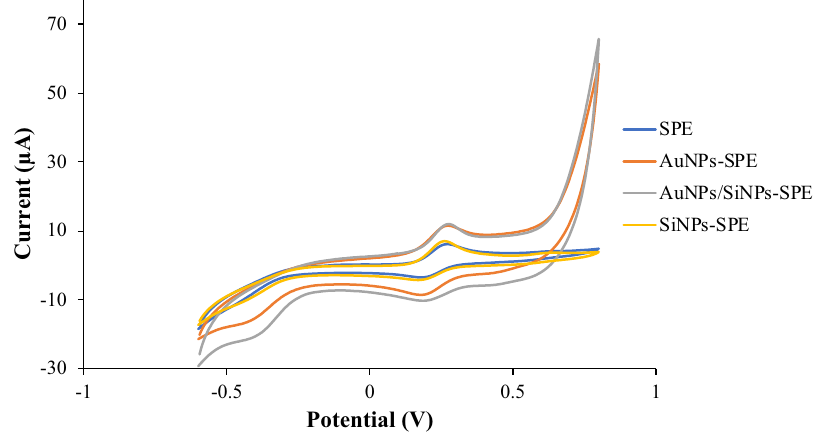
Figure 8. Cyclic voltammograms of 2 × 10 −4 M HexaFc complex from bare SPE (SPE), gold nanoparticles modified SPE (AuNPs-SPE), gold nanoparticles/silica nanospheres modified SPE (AuNPs/SiNSs-SPE), and silica nanospheres modified SPE (SiNSs-SPE) at a scan rate of 80 mVs −1 .